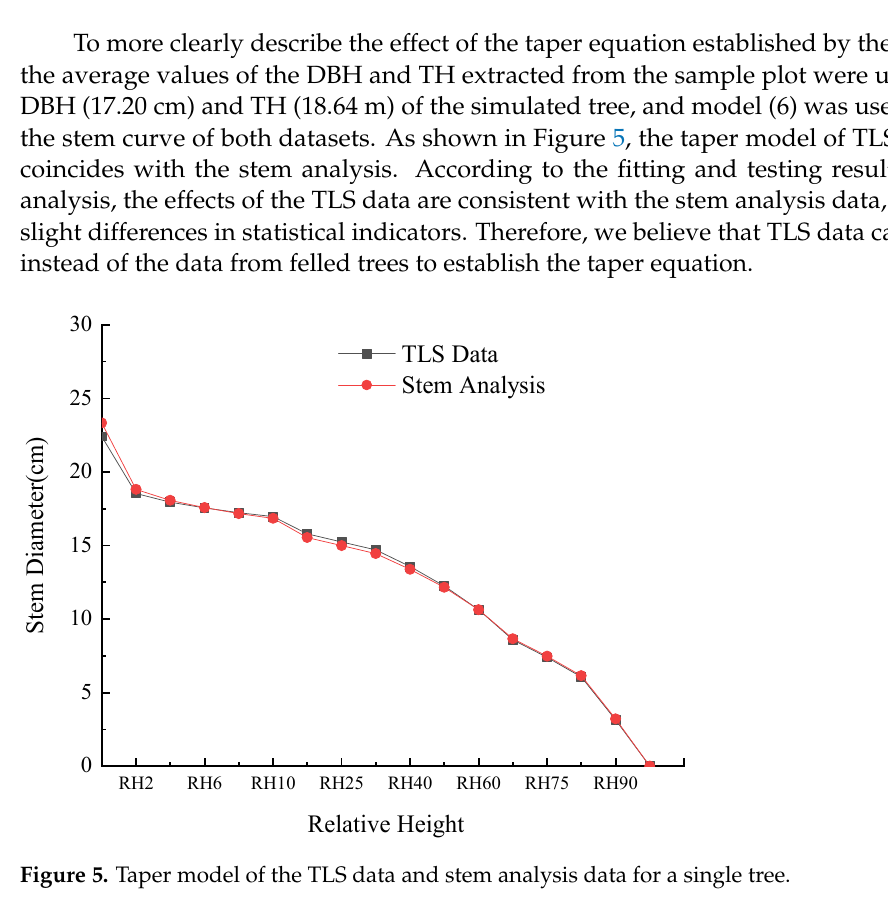
Table 6. Fitting and testing of the taper models with different relative heights.